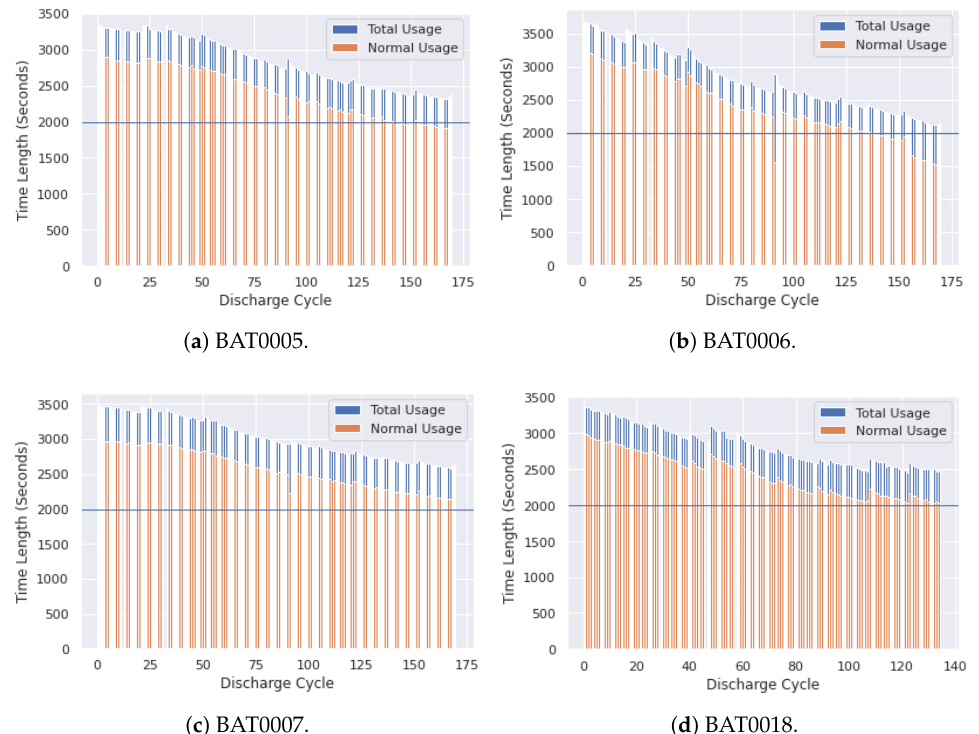
Figure 8. Normal usage phase time vs. total usage time before